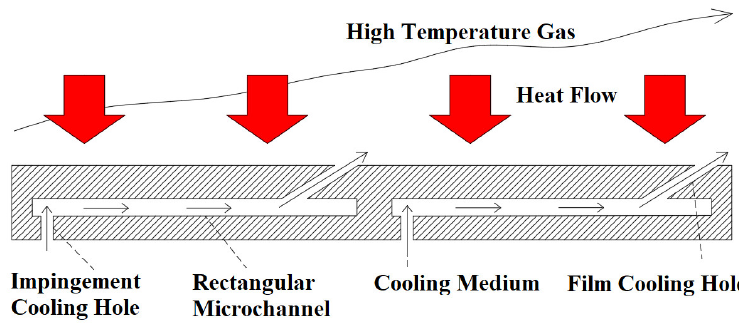
Figure 1. Subsurface micro cooling with rectangular microchannels [5].